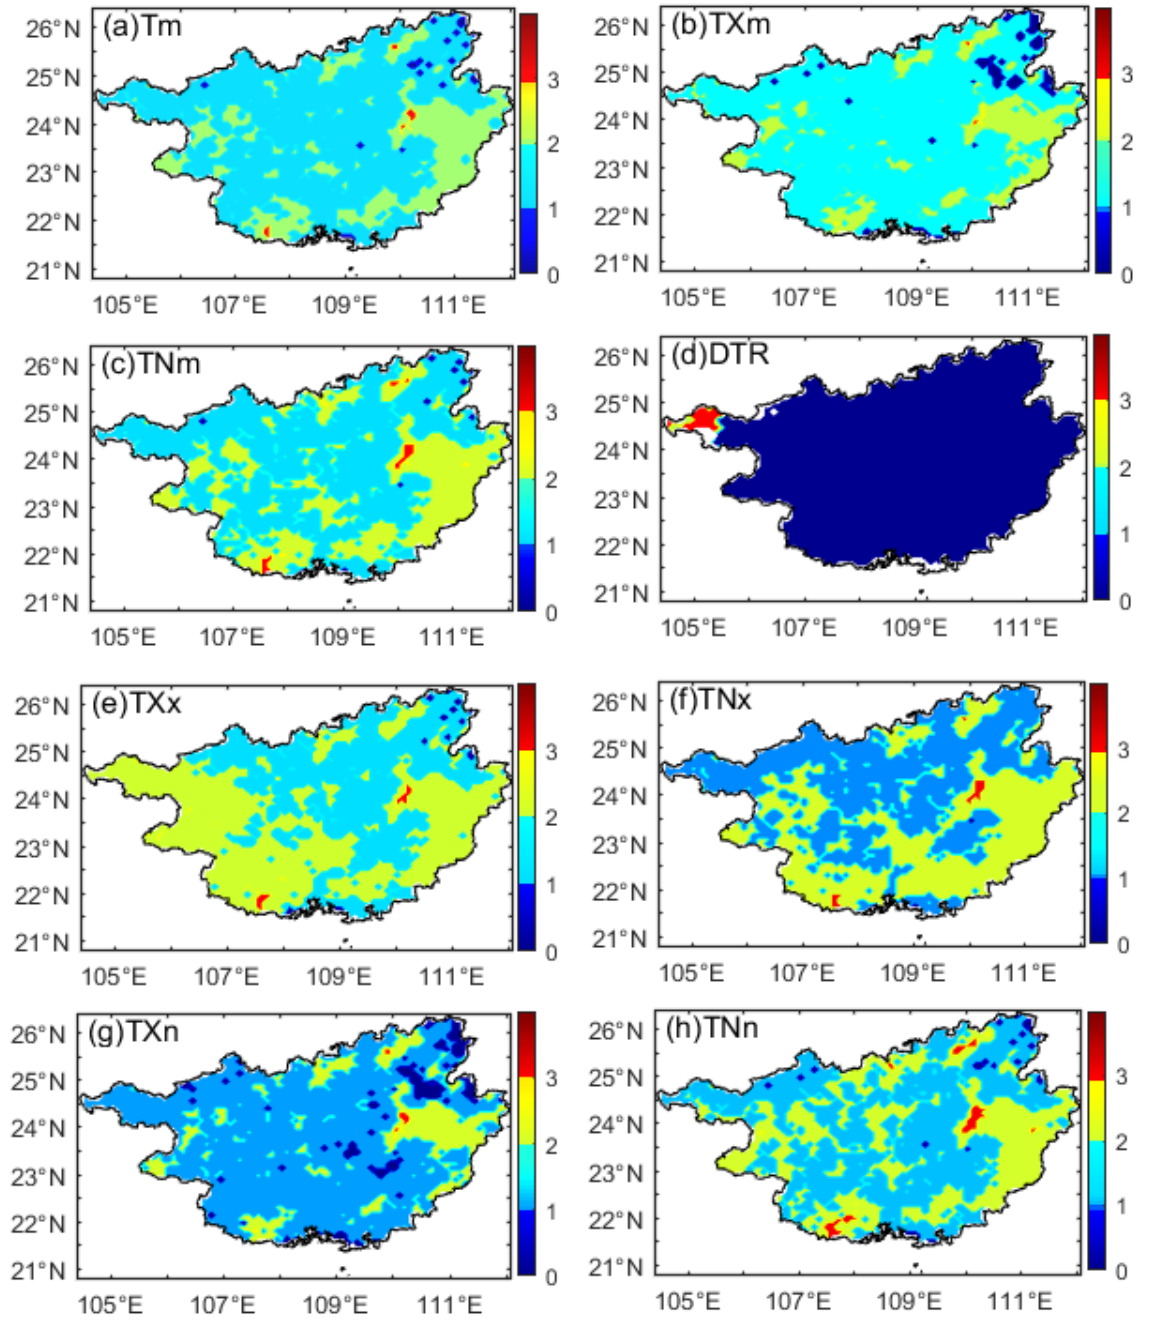
Figure 7. Spatial distributions of the time-lagged response of the NDVI to the temperature extremes: ( a ) Tm; ( b ) TXm; ( c ) TNm; ( d ) DTR; ( e ) TXx; ( f ) TNx; ( g ) TXn and ( h ) TNn. Note: ‘0’ NDVI and extreme climate indices were collected over the same period; ‘1–3’ NDVI lagged the extreme indices by 1–3 months. This study conducted four correlation analyses (namely, no lag, 1 month, 2 months, and 3 months), and the results of the four times were then superimposed to take the maximum value.